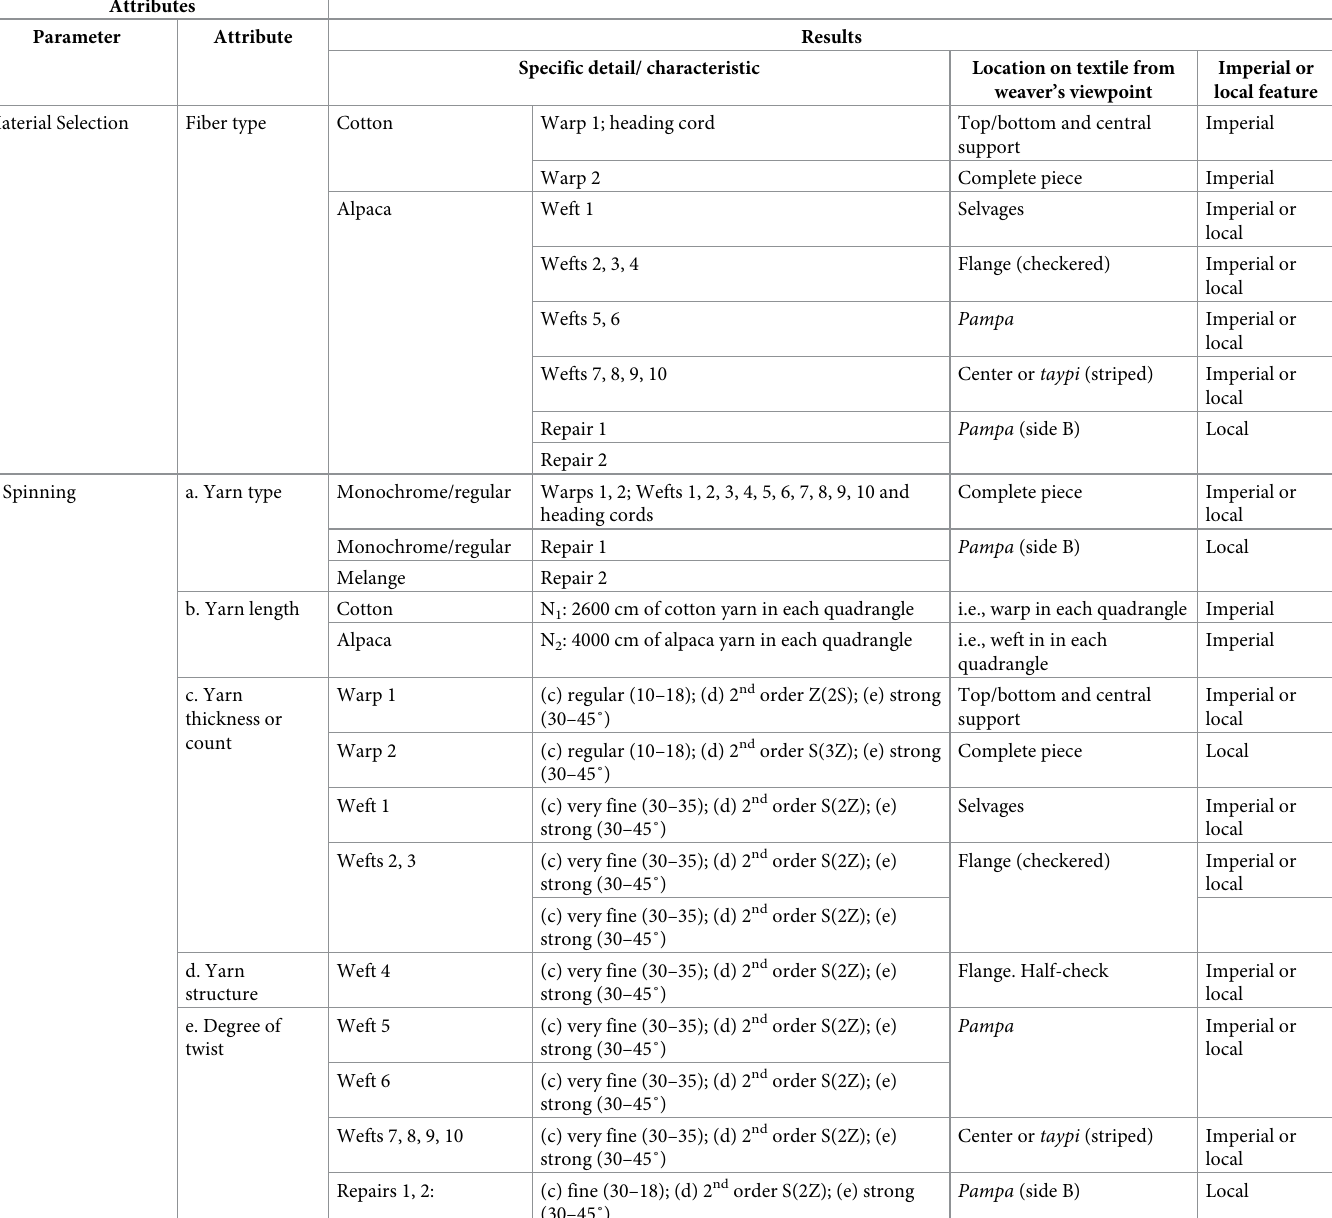
Table 2. Analytical